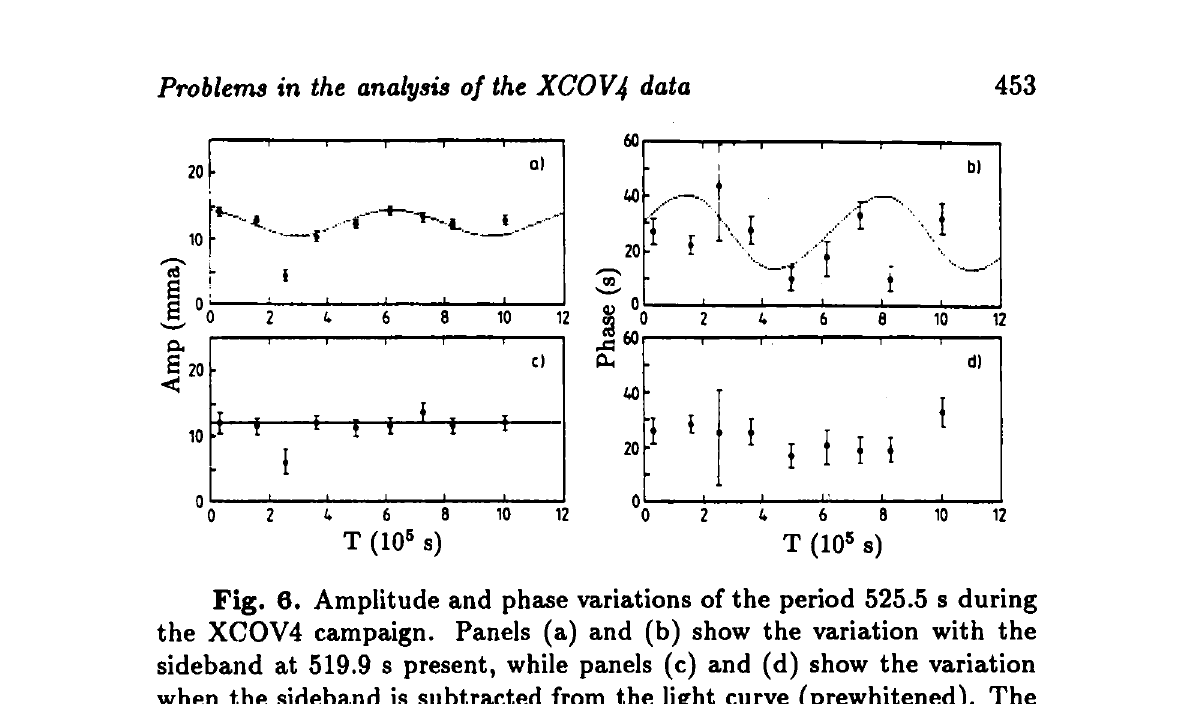
Fig. 6. Amplitude and phase variations of the period 525.5 s during the XCOV4 campaign. Panels (a) and (b) show the variation with the sideband at 519.9 s present, while panels (c) and (d) show the variation when the sideband is subtracted from the light curve (prewhitened). The curves in panels (a) and (b) show the modulations expected if the peak is an unresolved doublet of spacing 1.5 //Hz.